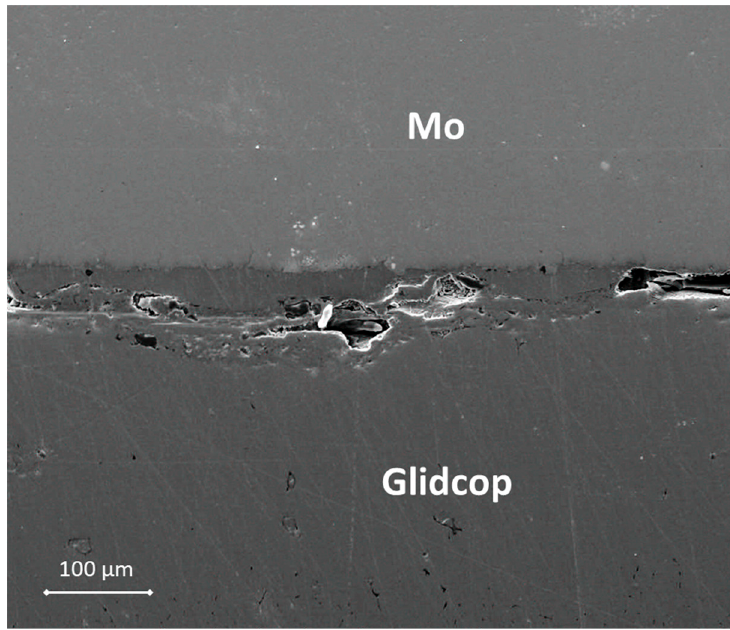
Figure 3. SEM micrograph of the cross-section of a Mo/Gemco/Glidcop joint manufactured by using one Gemco braze foil at 980 °C, 5 min, under flowing Ar and applying 0.02 MPa.